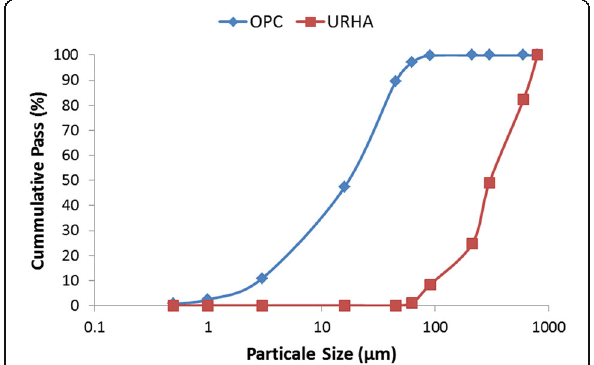
Fig. 1 Particle size distribution of OPC and